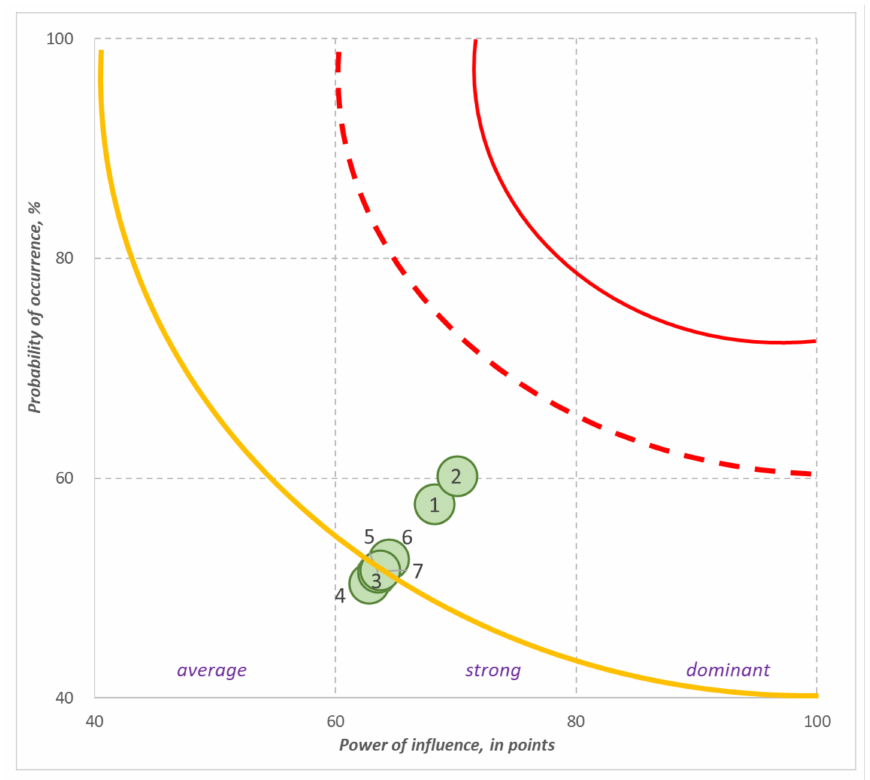
Figure 9. Expert assessment of opportunities for the development of the electric power industry in Kazakhstan. Source: compiled by the authors based on the results of the